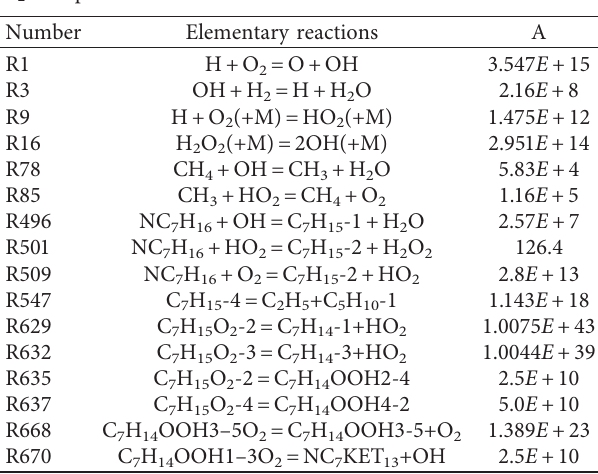
Figure 9: Ratio of the second-stage ignition delay time of different initial temperatures for methane/H and ϕ � 1. Table 1: Important reactions for the ignition processes of methane/ H 2 /n-heptane